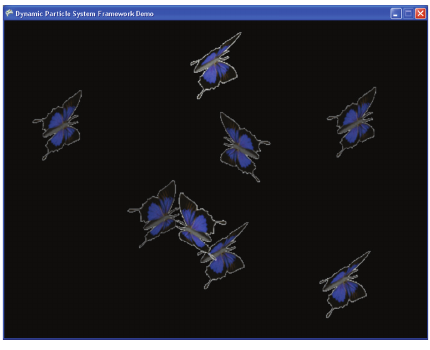
Figure 7: Animated butterfly